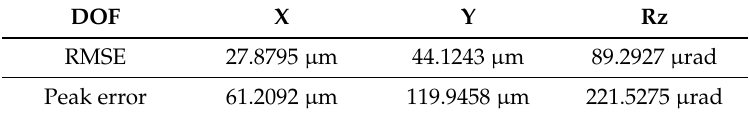
Table 2. The output errors of the 3-DOF with designed values of parameters using Model (15). DOF X